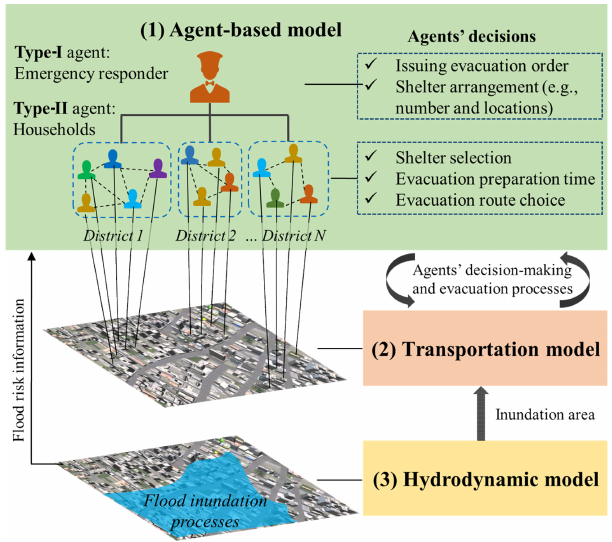
Figure 1. Illustration of the integrated modeling framework that couples an ABM for simulating household decision-making and emergency responders’ flood management policies, a transportation model for simulating residents’ evacuation processes in a road net- work, and a hydrodynamic model for simulating flood inundation